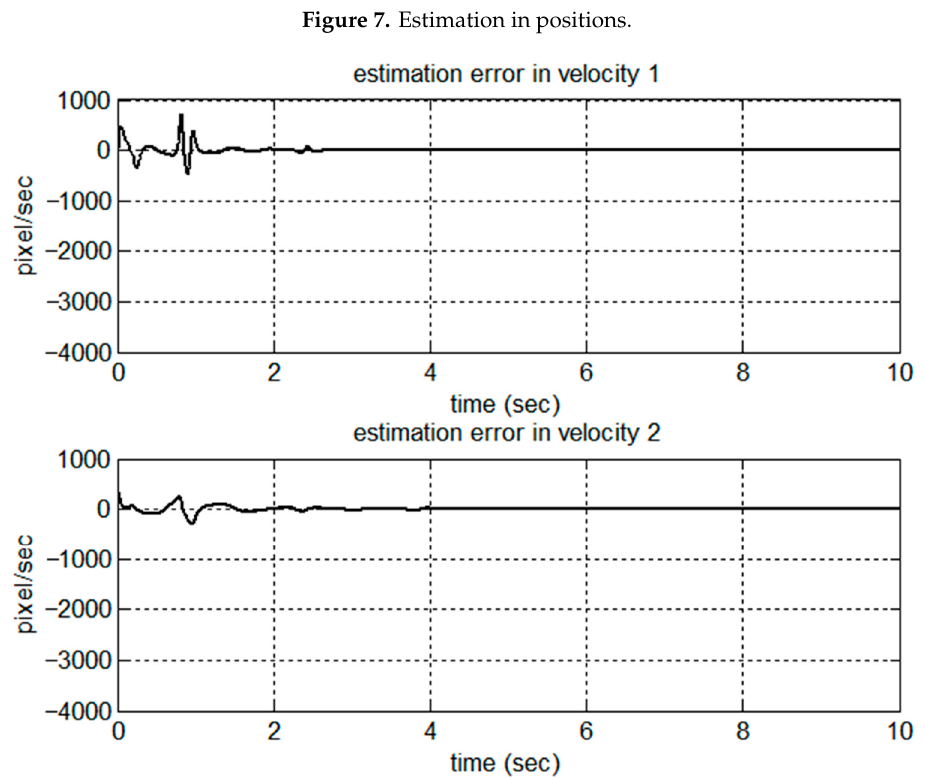
Figure 8. Estimation error in velocities.